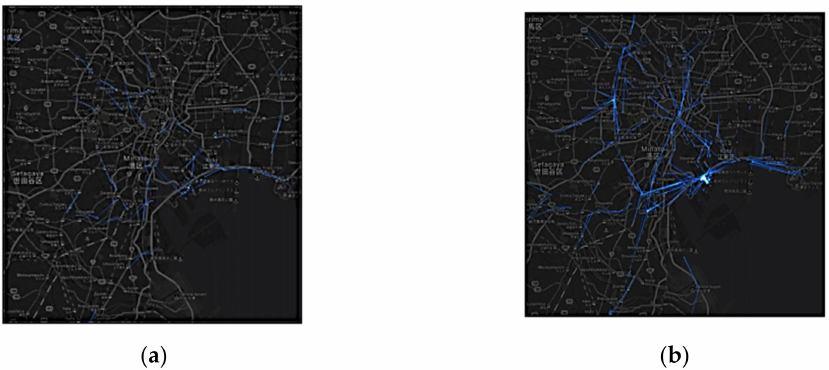
Figure 6. Rare crowd behaviors: ( a ) 2 August 2011, 7–9 AM; ( b ) 12 August 2011, 7–9 AM [40].